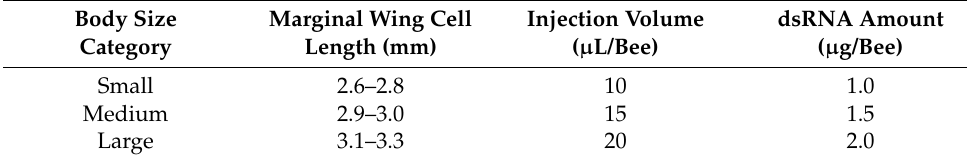
Table 1. Injection volumes and RNA amounts injected into bees of different body